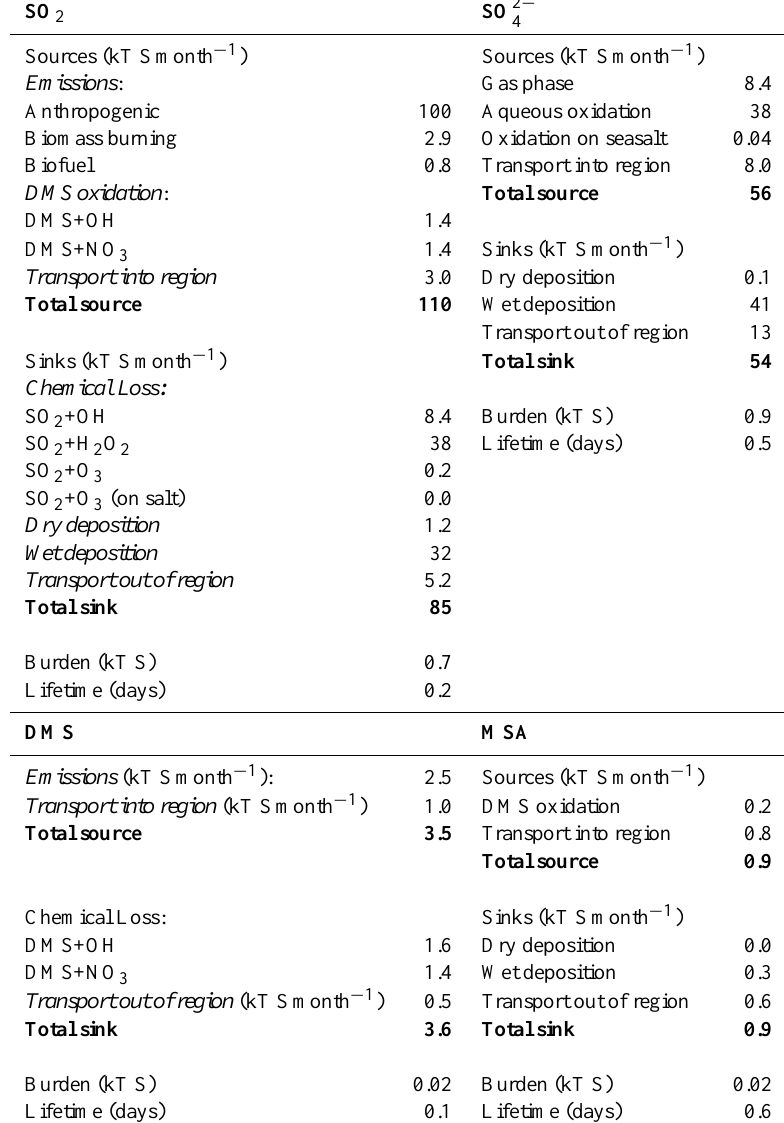
Table 5. GEOS-Chem model sulphur budget over Borneo, 25 June–25 July 2008. SO